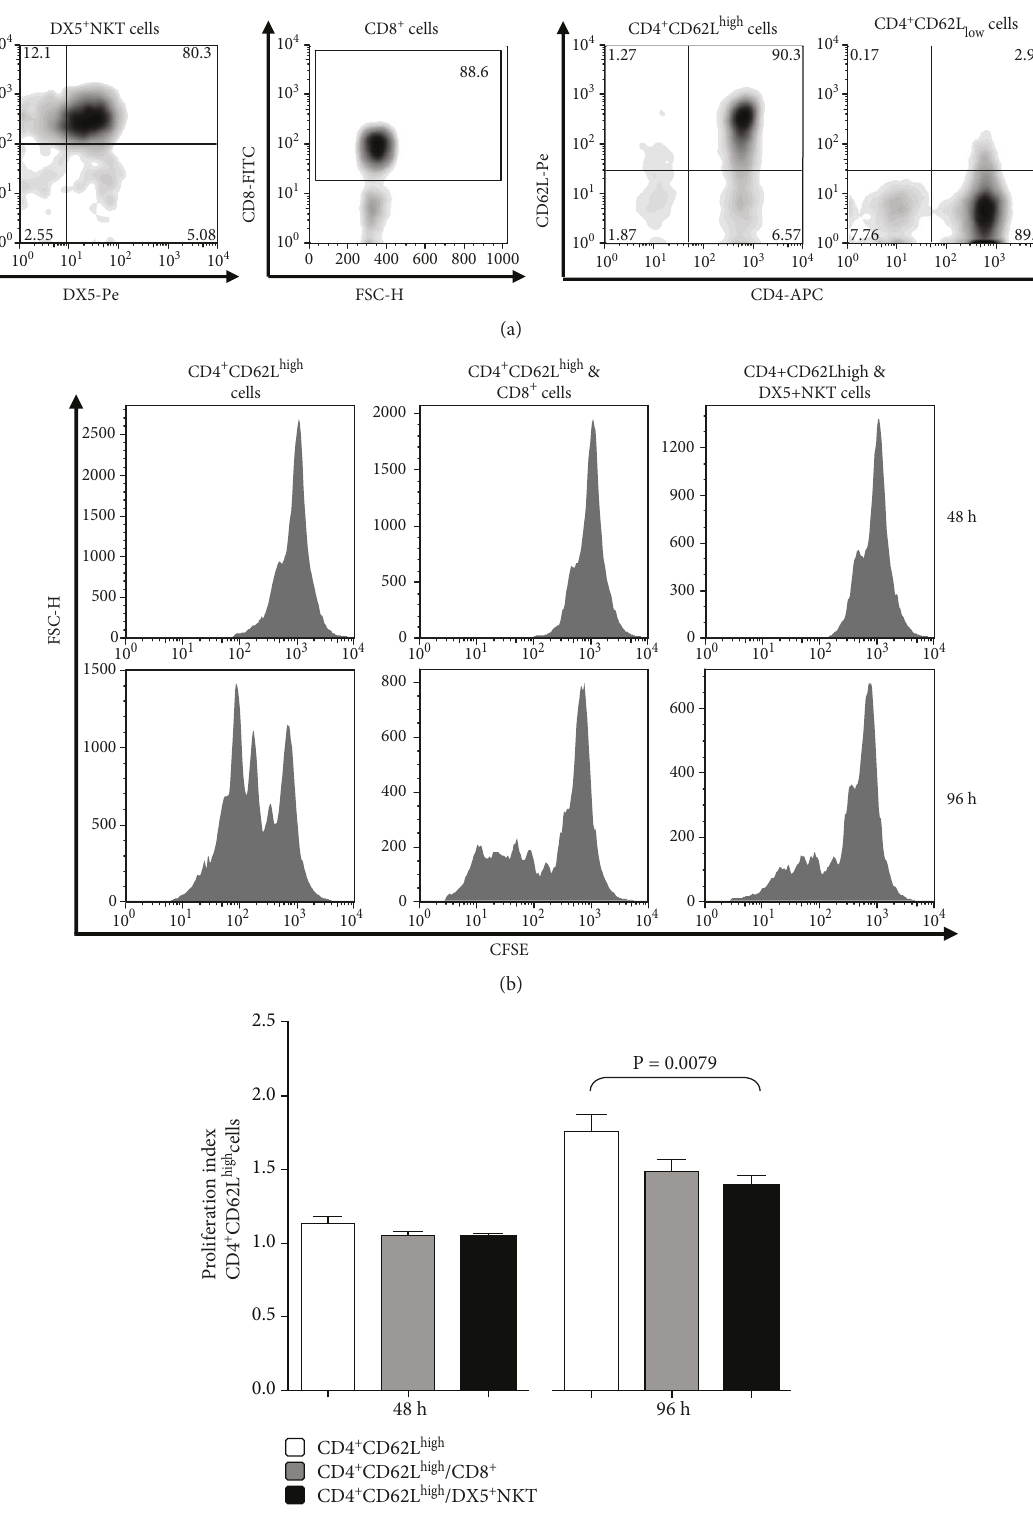
Figure 1: Flow cytometry analysis of the spleen CD3 + DX5 + NKT, CD8 + T, CD4 + CD62L high , and CD4 + CD62L separation by MACS and FACS sorting (a). Proliferation (b) and proliferation index (c) of CFSE-labeled CD4 + CD62L high cells after 48 h and 96h of monoculture or coculture with CD8 + T cells or CD3 + DX5 + NKT. Results are given as mean +SEM. Experiments were repeated at least three times ( ∗ P < 0 05